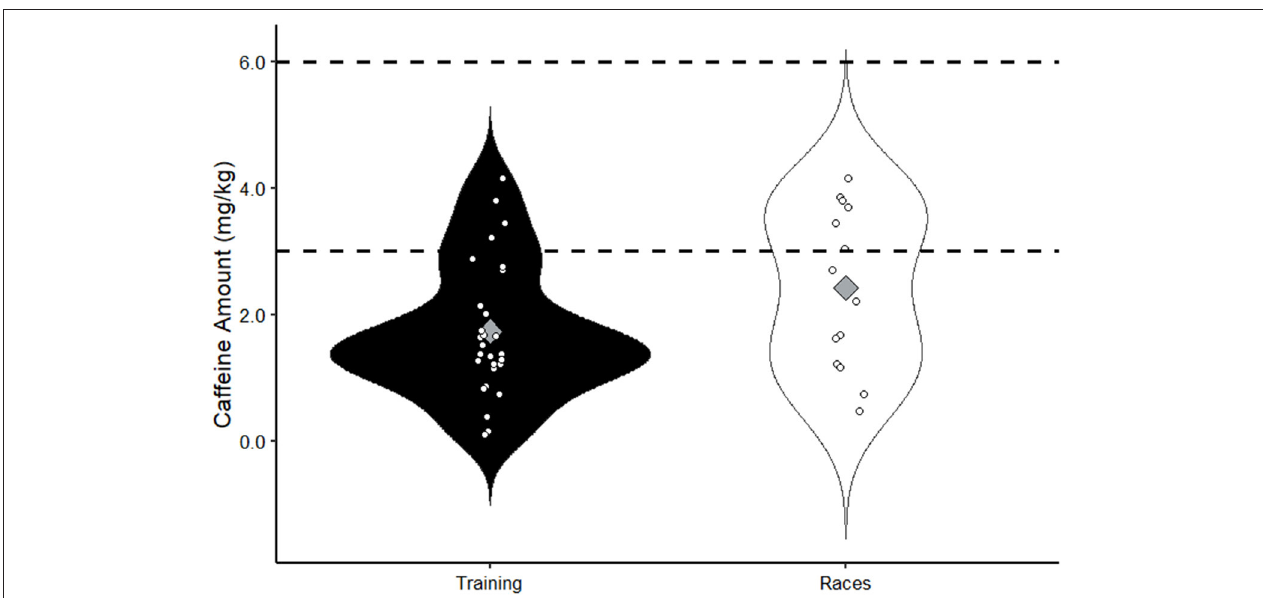
FIGURE 3 | Reported caffeine amount ingested prior to training and races; white dots represent individual data points; gray diamonds represent means; dashed lines show typical caffeine amounts administered 60min before exercise in laboratory studies (3–6 mg/kg).